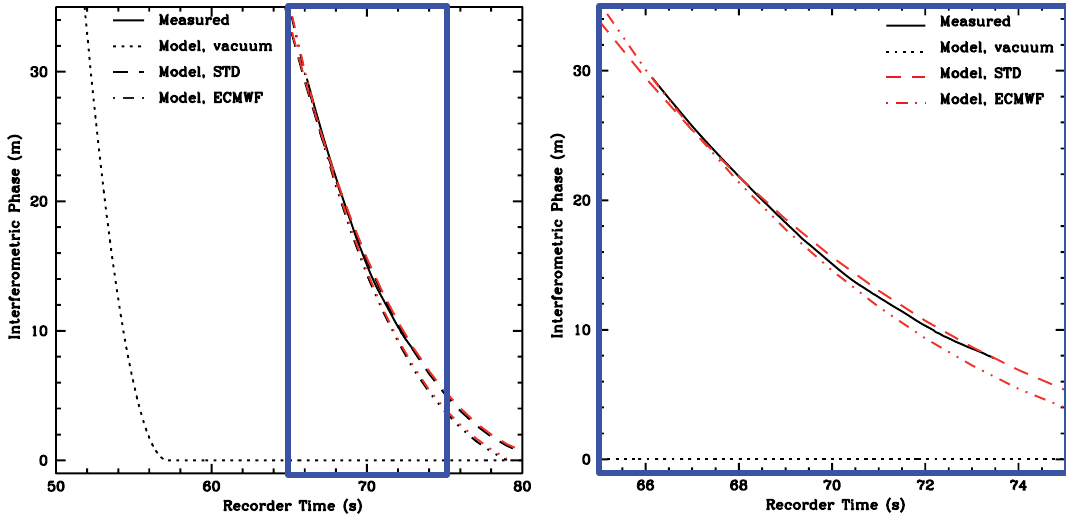
Fig. 5. Path difference between direct and reflected signals over sea using interferometric phases measured and evaluated with raytracing. Black evaluated curves do not use ionosphere correction. Red evaluated curves use COSMIC’s estimation. On right hand side a zoom of the same path difference is